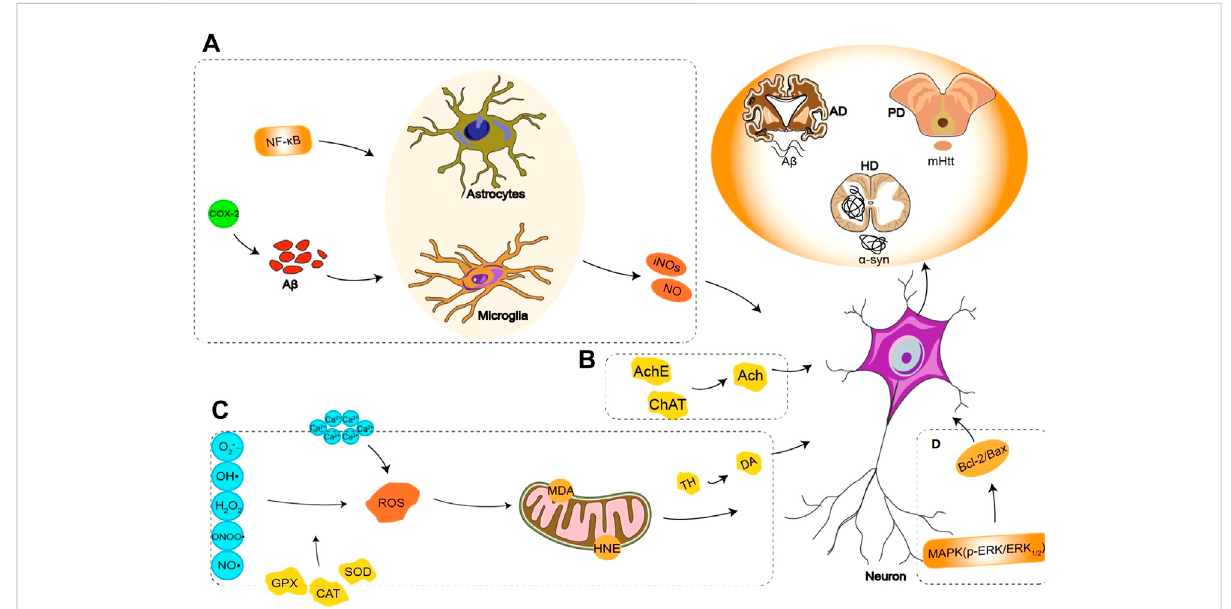
FIGURE 2 Signal pathways related to neuroprotective effect of Valeriana : (A) anti-in fl ammatory, inhibiting the activation of caspase-3, decreasing the activity of COX-2 and microglia and astrocytes, reducing the overexpression of iNOS and the in fl ammatory injury to cortical and hippocampal neurons. (B) Enhancing the activity of ChAT and increasing the level of Ach in the cerebral cortex and hippocampus. (C) Antioxidant, increasing the activities of SOD and GSH-Px and reducing the level of lipid peroxide MDA, upregulating the levels of DA and TH, increasing the number of midbrain tyrosine hydroxylase positive cells, enhancing antioxidant activity. (D) Anti-apoptotic, activating the p-ERK and Bcl-2 signaling pathways and inhibiting the Bax pathway to protect the brain neurons from A β 1-42 induced